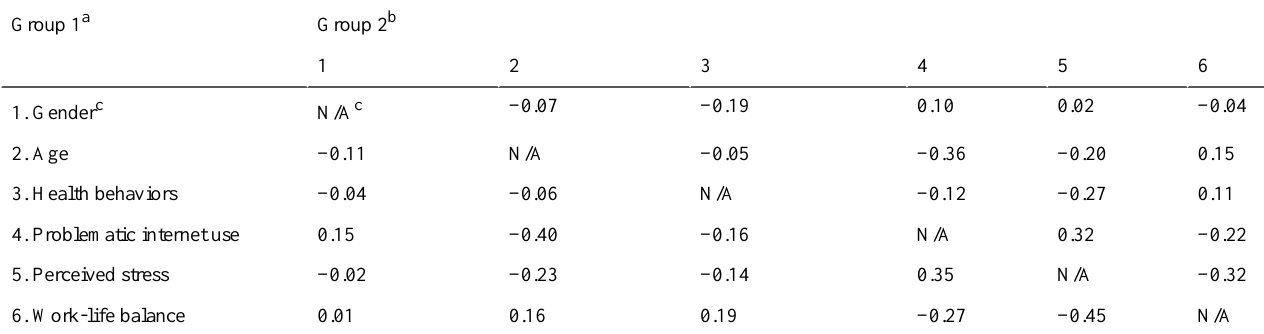
Table 2. Pearson correlation of variables in 2